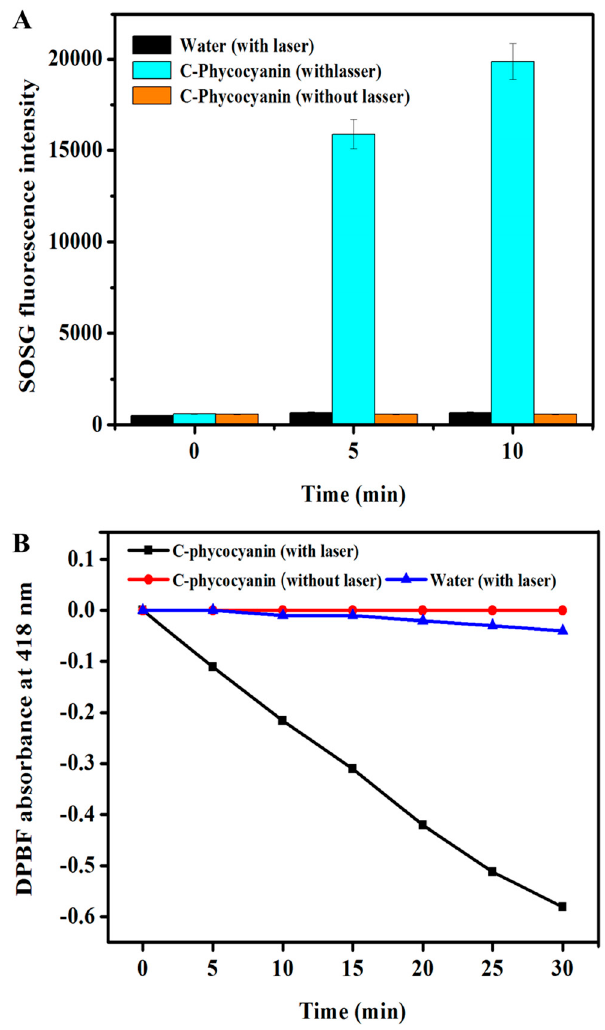
Figure 2. Screening of free radical generation efficacy by c-phycocyanin under 625-nm laser illumination at 80 mW · cm − 2 using SOSG ( A ) and DPBF ( B ) assays.